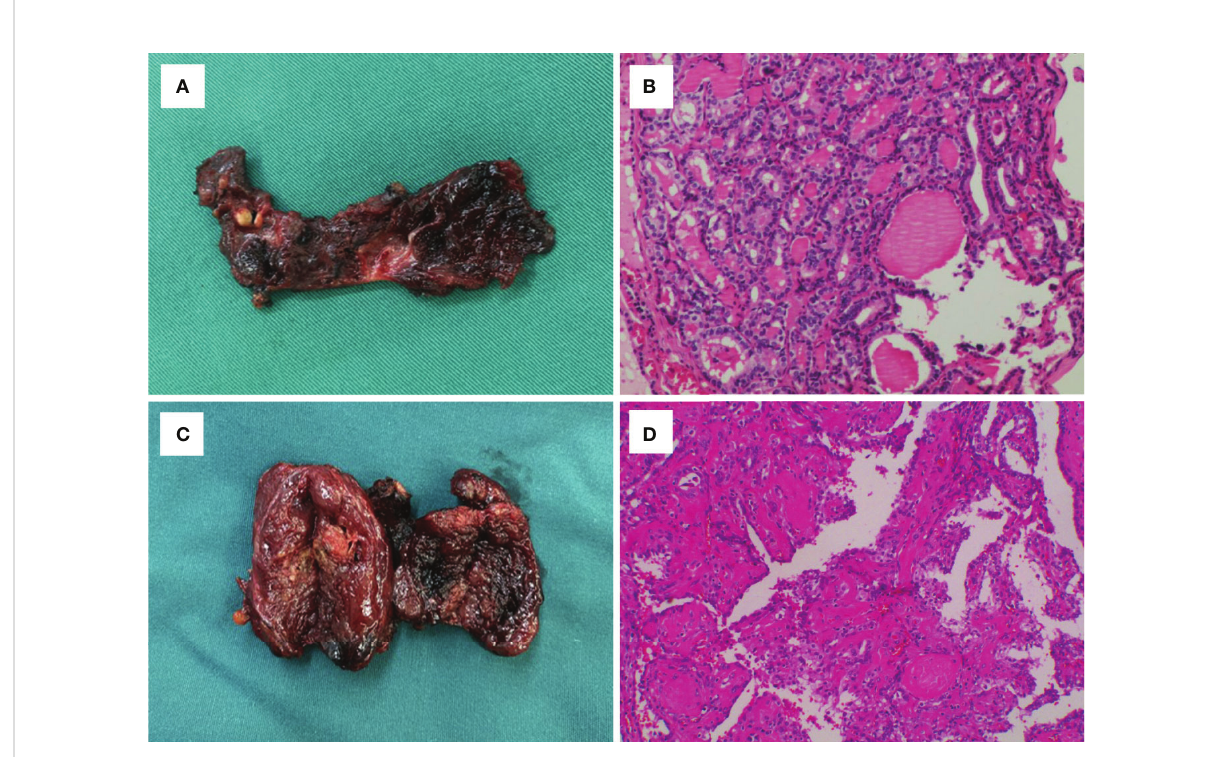
FIGURE 3 Gross fi ndings and histological outcomes in case 11 (A, B) and case 12 (C, D) , which showed tumor recurrence in the post-ablation lesions.